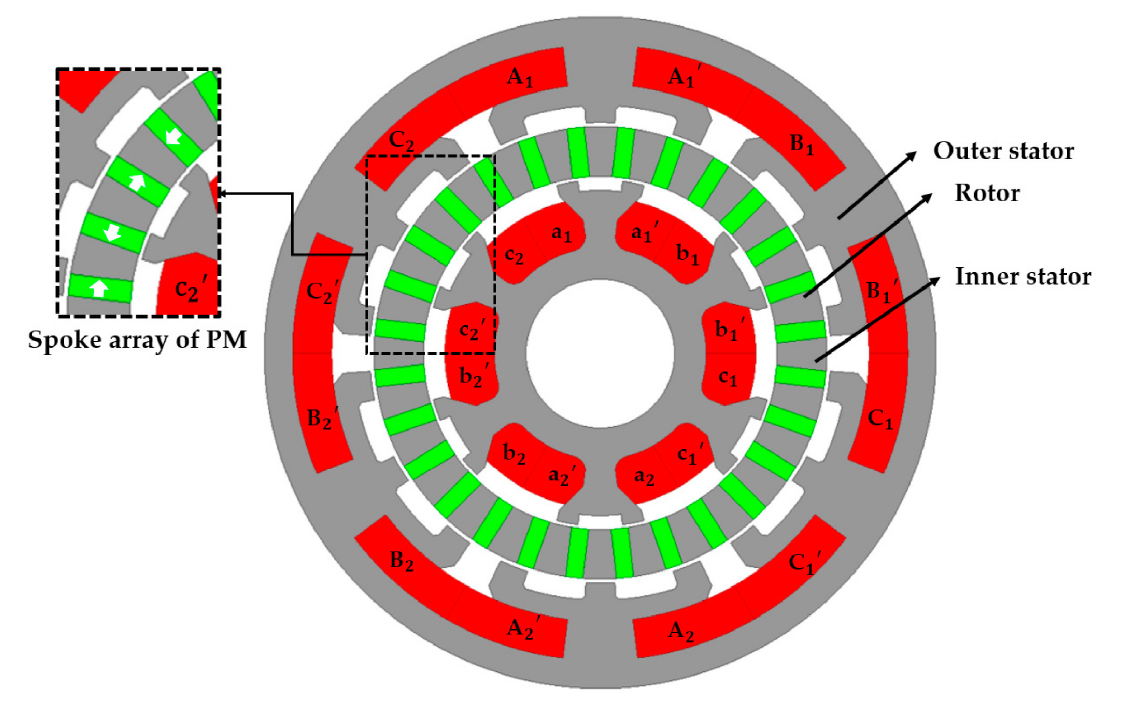
Figure 6. Geometry of a dual-stator permanent magnet Vernier motor [150].